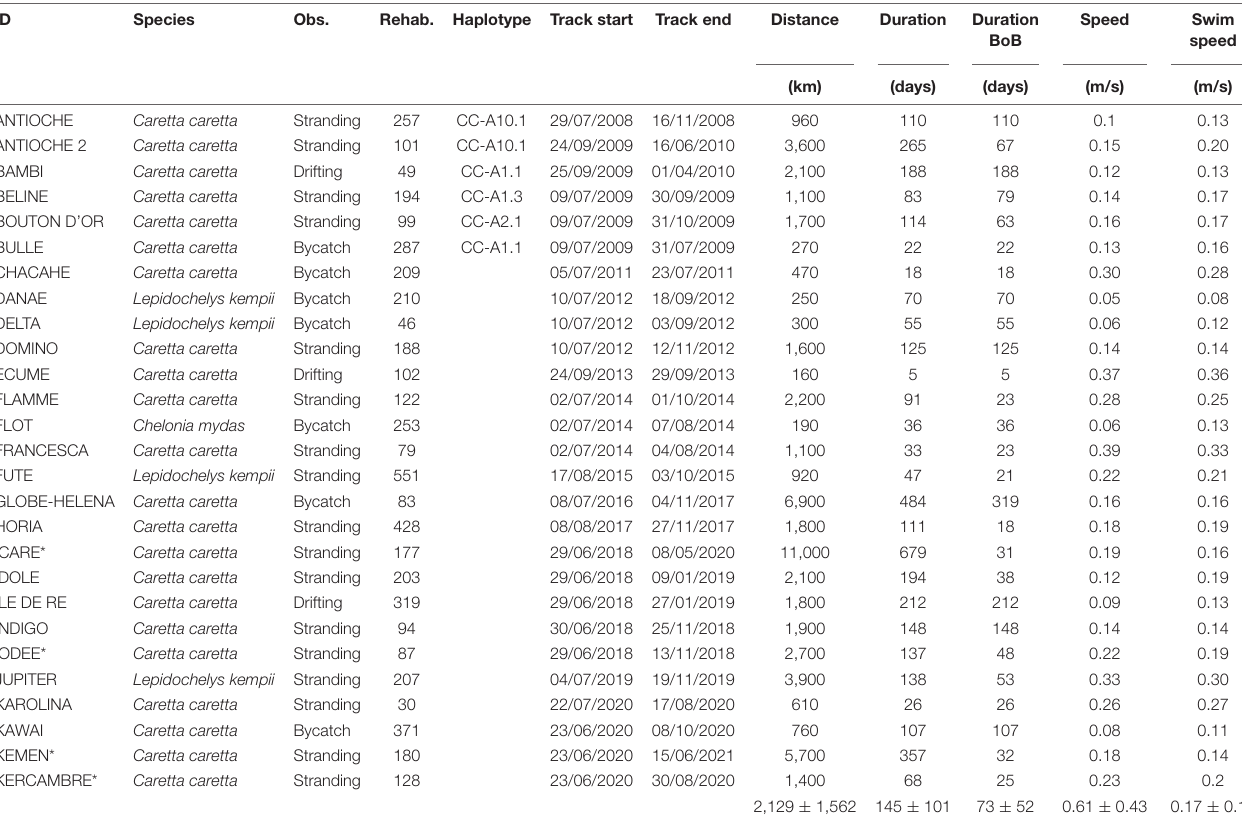
TABLE 1 | Characteristics of the rescued turtles and after release with the satellite tags. ID Species